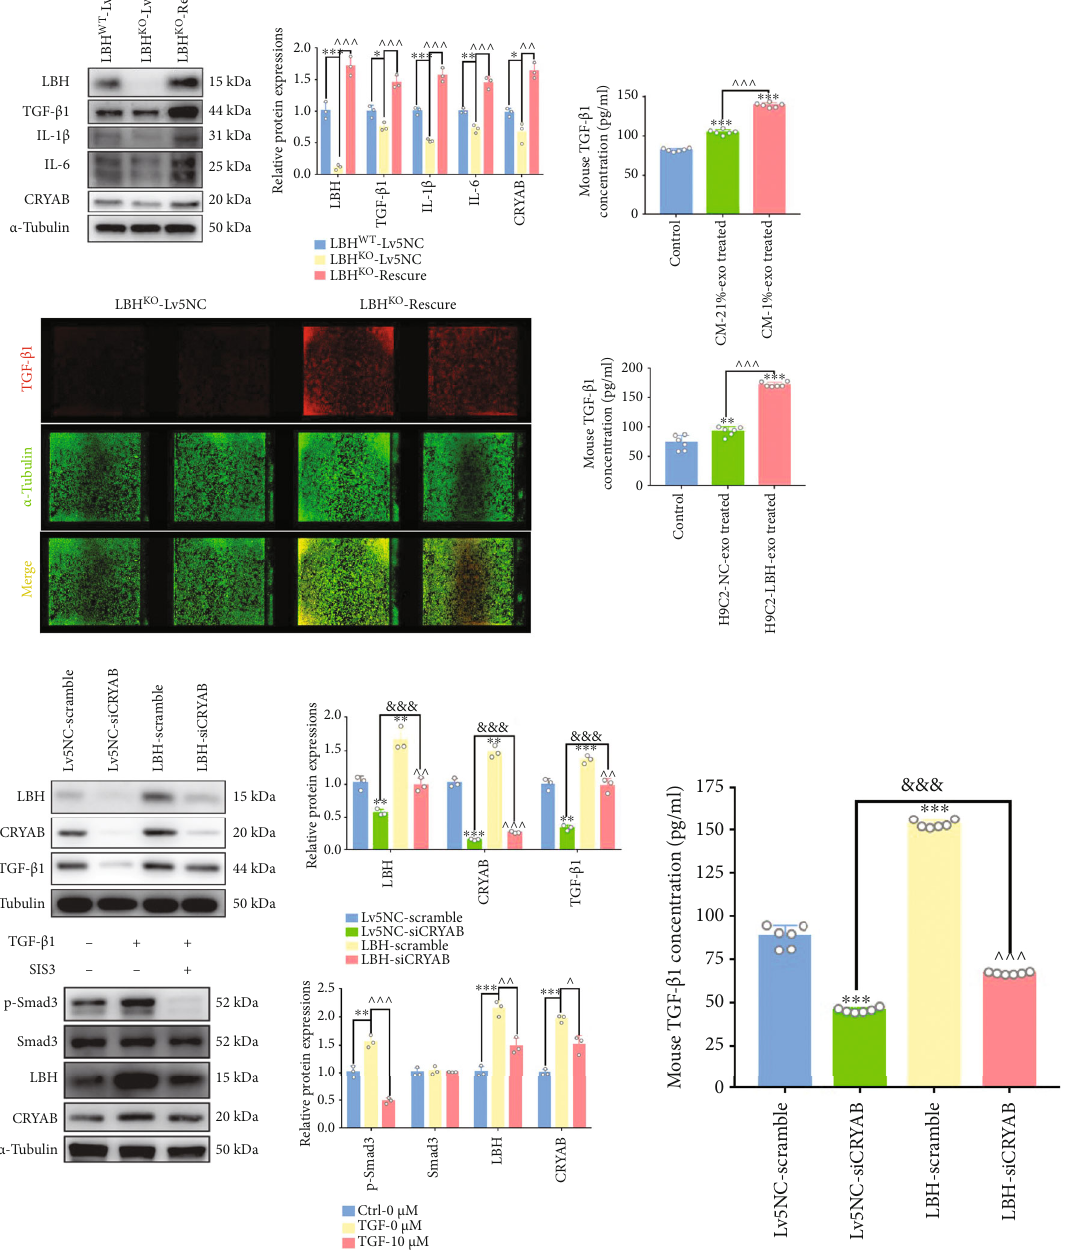
Figure 6: LBH a ff ects TGF- β 1 expression and signaling through a positive feedback loop. (a) Protein levels of LBH, CRYAB, TGF- β 1, IL-1 β , and IL-6 in LBH KO mouse CFs rescued by lentiviral-induced LBH upregulation ( ∗ p < 0 : 05 , ∗∗ p < 0 : 01 , and ∗∗∗ p < 0 : 001 vs. LBH WT -Lv5NC; ∧∧ p < 0 : 01 and ∧∧∧ p < 0 : 001 vs. LBH KO - Lv5NC). (b) In cell western simultaneously testing, the protein levels of TGF- β 1 (red) and α - tubulin (green) in LBH KO mouse CFs transfected with Lv5NC or LBH lentivirus. (c) Secreted TGF- β 1 in the cell supernatants of mouse CFs treated with LBH+ exosomes, together with LBH KO CFs rescued by LBH-overexpressing lentivirus, were measured by ELISAs ( ∗∗∗ p < 0 : 001 vs. Control/LBH WT -LvNC; ∧∧∧ p < 0 : 001 vs. CM-21%-Exo-treated/LBH KO -Lv5NC). Protein expression of LBH, CRYAB, TGF- β 1 (d), and TGF- β 1 secretion (e) in mouse CFs after LBH overexpression and subsequent CRYAB knockdown ( ∗∗ p < 0 : 01 and ∗∗∗ p < 0 : 001 vs. Lv5-NC-Scramble; &&& p < 0 : 001 for Lv5-NC-siCRYAB vs. LBH-siCRYAB; ∧∧ p < 0 : 01 and ∧∧∧ p < 0 : 001 for LBH-Scramble vs. LBH-siCRYAB). (f) Protein levels of LBH, p-Smad3 and Smad3 in TGF- β 1-stimulated mouse CFs with or without treatment with the phosphorylation inhibitor SIS3 ( ∗∗ p < 0 : 01 and ∗∗∗ p < 0 : 001 vs. Ctrl-0 μ M SIS3; ∧ p < 0 : 05 , ∧∧ p < 0 : 01 , and ∧∧∧ p < 0 : 001 vs. TGF-0 μ M